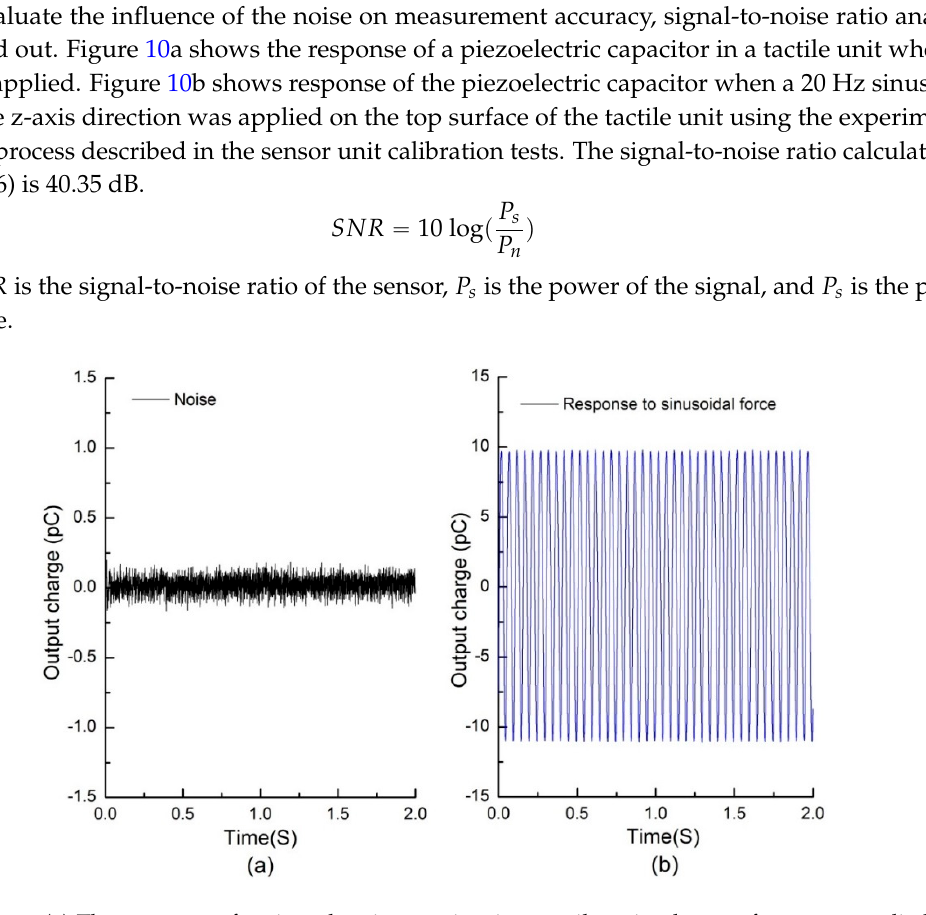
Table 1. Applied and calculated force components on the sensor array.